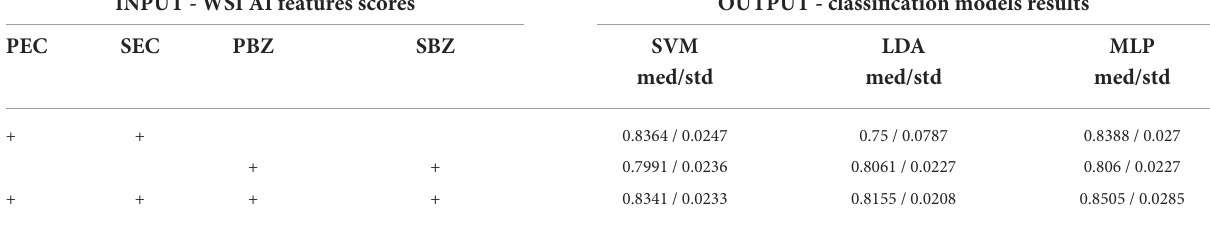
TABLE 2 Classification results of multiple models (SVM, LDA, and MLP) with different combinations of input features (PEC, SEC, PBZ, and